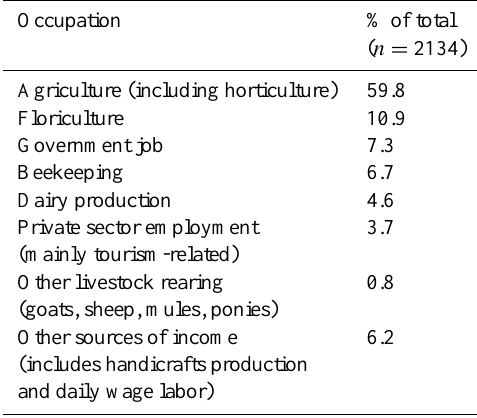
Table 3. NDBR household member occupations (reported for all members of surveyed households).